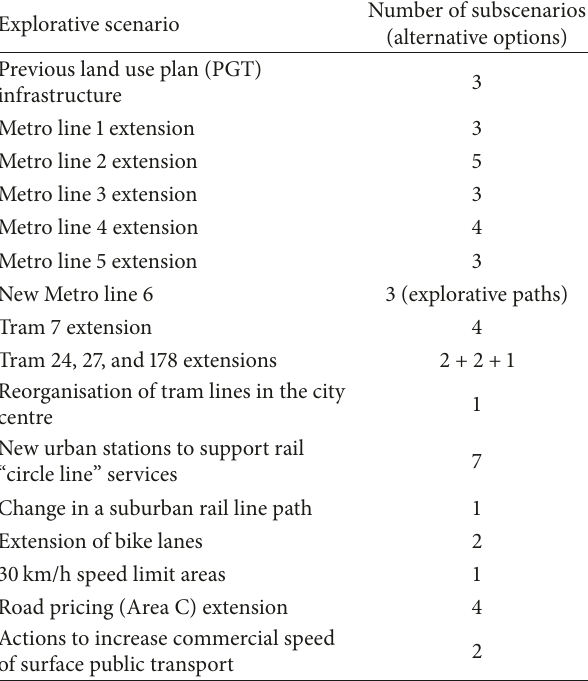
Table 2: SUMP explorative